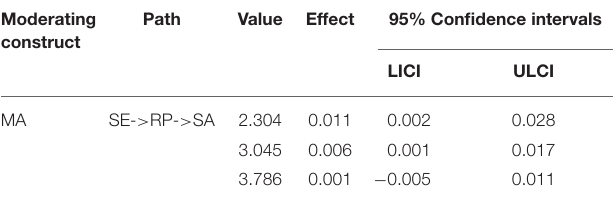
TABLE 8 | Result of moderating effect during pandemic ( N =